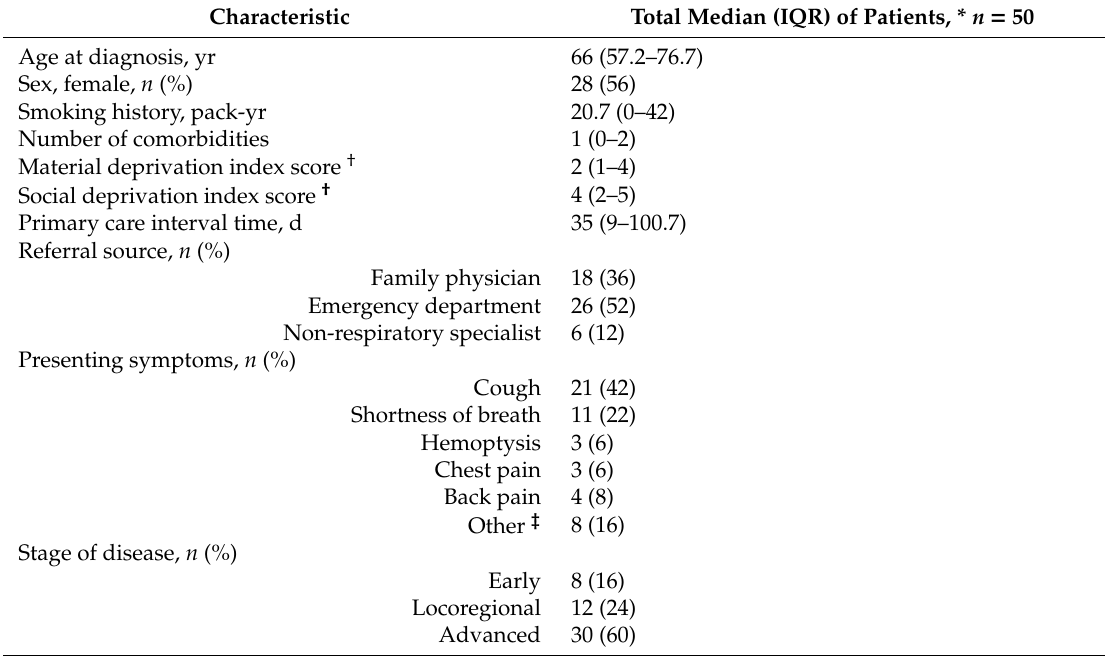
Table 1. Characteristics of patients included in the study.